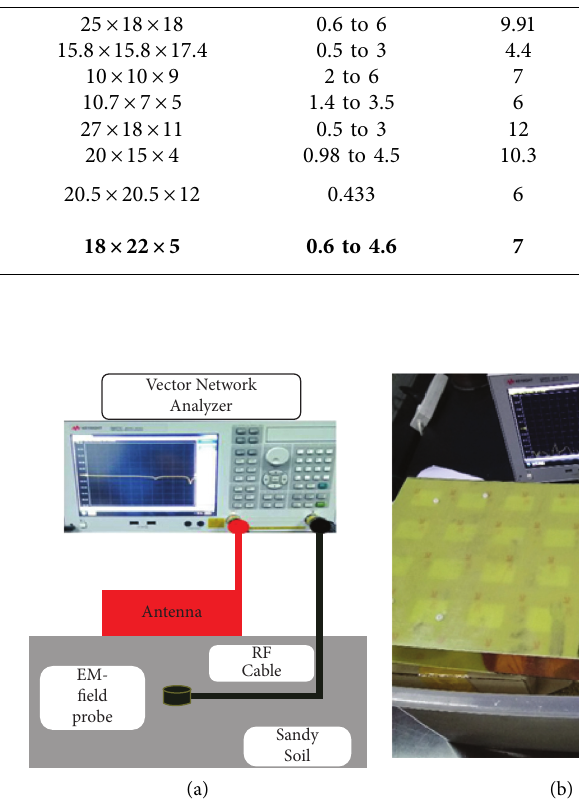
Figure 11: Simulated and measured E-plane radiation pattern of reflector-backed RLSPA: (a) 1GHz; (b) 2 GHz; (c) 3GHz; (d) 4 GHz. Table 1: Proposed antenna’s comparative analysis with already existing antennas. Reference